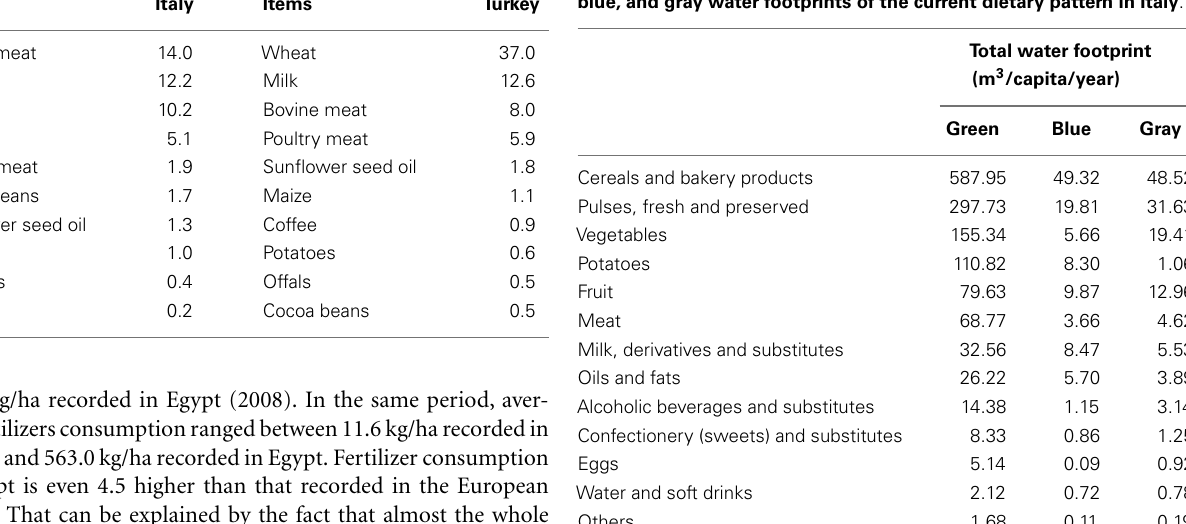
Table 7 | Contribution of different food product groups to the green, blue, and gray water footprints of the current dietary pattern in Italy